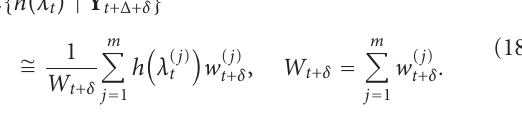
Algorithm 3 (multilevel MKF). Suppose, at time ( t − 1), a